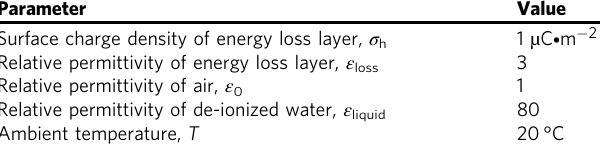
Table 1 Parameters for the electrostatic simulation Parameter